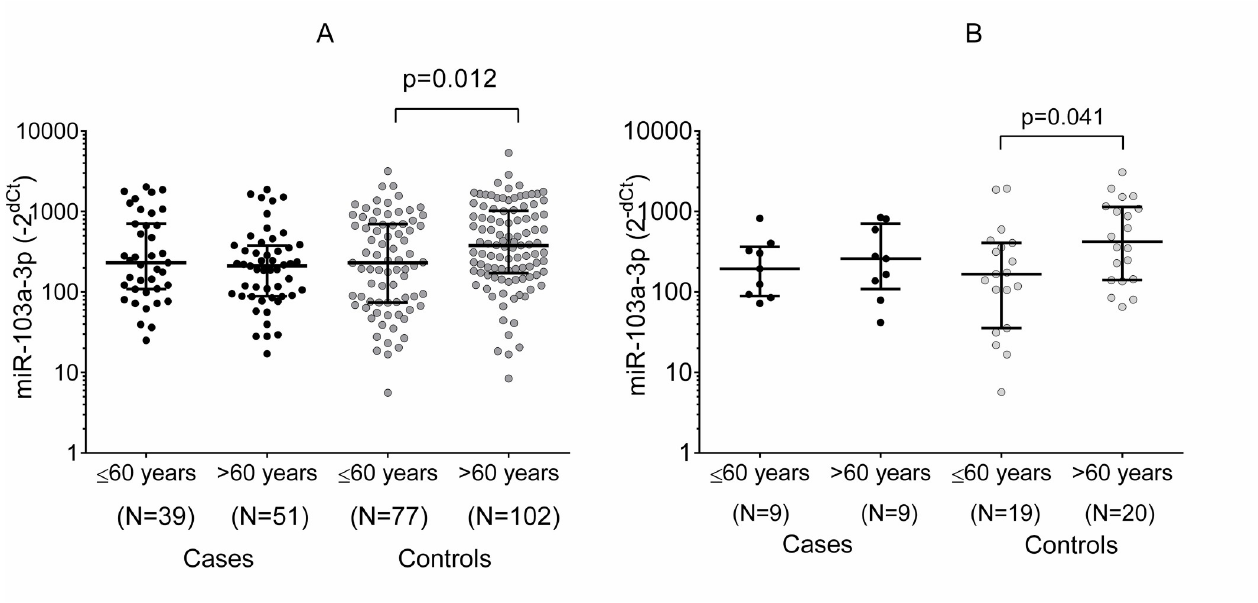
Fig 2. Distribution of miR-103a-3p medians between malignant pleural mesothelioma cases and controls grouped by age and sex [men (A) and women (B)] in a Mexican population. Black dots represent cases, and gray dots controls.